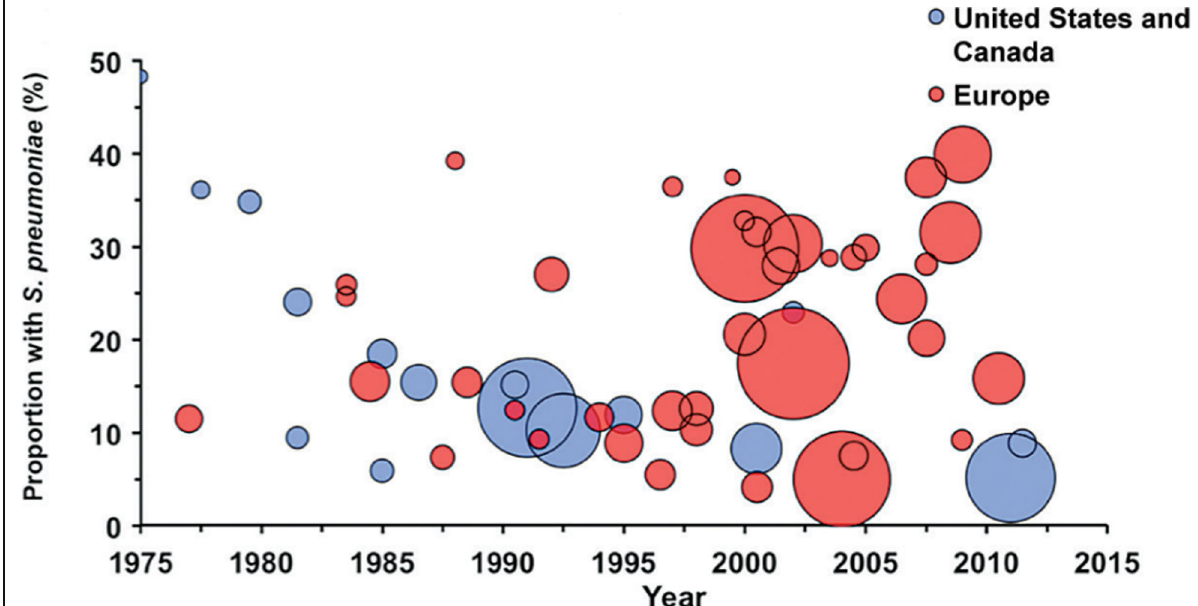
Fig. 3 The proportion of S. pneumoniae as the causes of CAP in US and Canada vs. all other geographic regions (reprinted with permission from Musher et al.